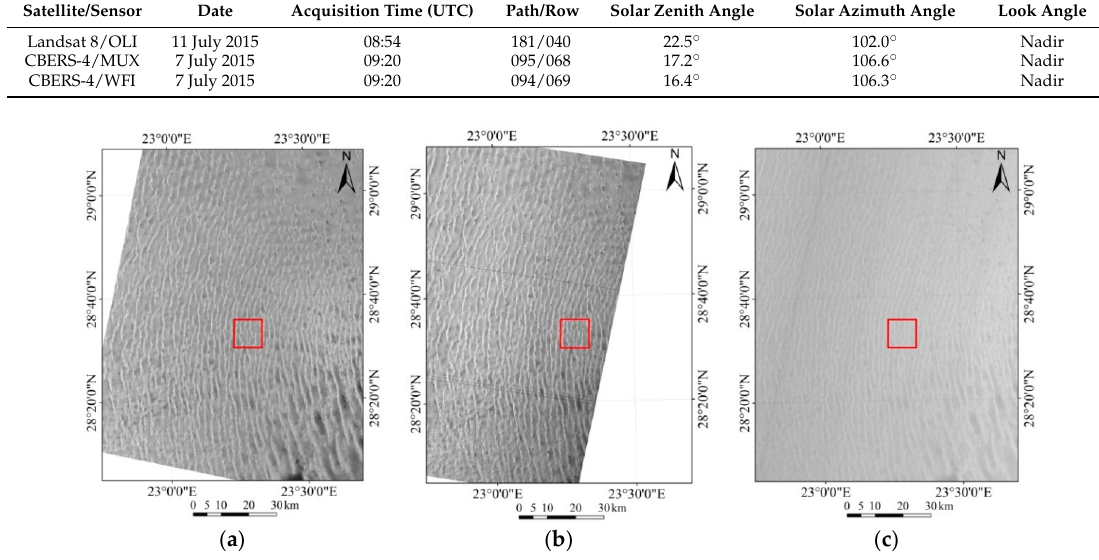
Table 3. Metadata of scenes used for MUX, WFI/OLI cross-calibration.